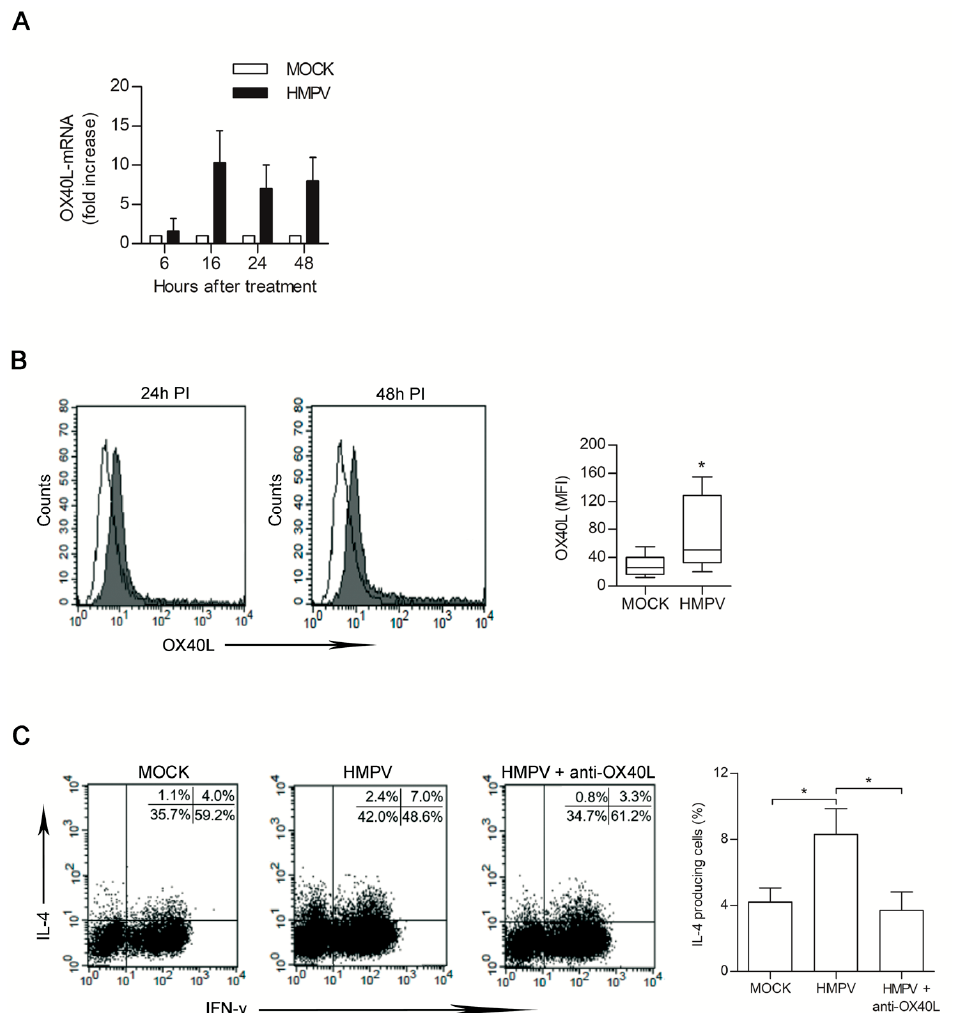
Figure 4. HMPV-infected secretome (21 days PI) induces OX40L expression in dendritic cells (DCs). ( A ) DCs treated with mock and HMPV-secretome were harvested at the indicated times. OX40L transcripts were analysed by rtPCR and mRNA levels were normalized using β -actin mRNAs detected in the same samples. Results are expressed as fold induction over the levels detected in mock cells at the same time points. Bars represent the mean ± SD of five independent experiments. ( B ) Left panel: Flow cytometric analysis of OX40L expression on DC surface. DCs were analysed for OX40L expression upon 24 h and 48 h of treatment with mock (open line) or HMPV-infected (solid line) secretomes. Histograms are from one representative experiment. Box-plots in the right panel show the mean florescence intensity (MFI) values of OX40L expression from 10 independent experiments. Lower quartile, median, upper quartile, and largest observations are represented. * p < 0.05. ( C ) Naïve CD4 T cells were cultured with DCs primed with HMPV-infected secretome in the presence or absence of anti-OX40L neutralizing mAb. After seven days, cells were analysed by flow cytometry for intracellular expression of IFN- γ and IL-4. Dot-plots in the left panel represent one out of the three independent experiments performed; numbers indicate the % of positive cells in each quadrant. Bars in the right panel represent the mean % ± SEM of IL-4-producing cells of three performed experiments upon the indicated treatment. * p <